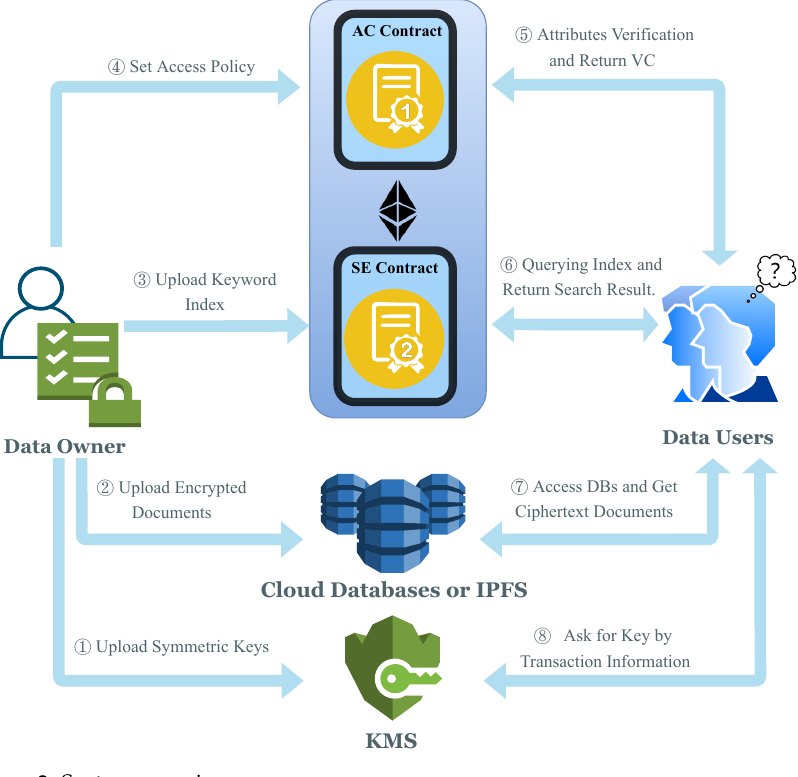
Figure 2. System